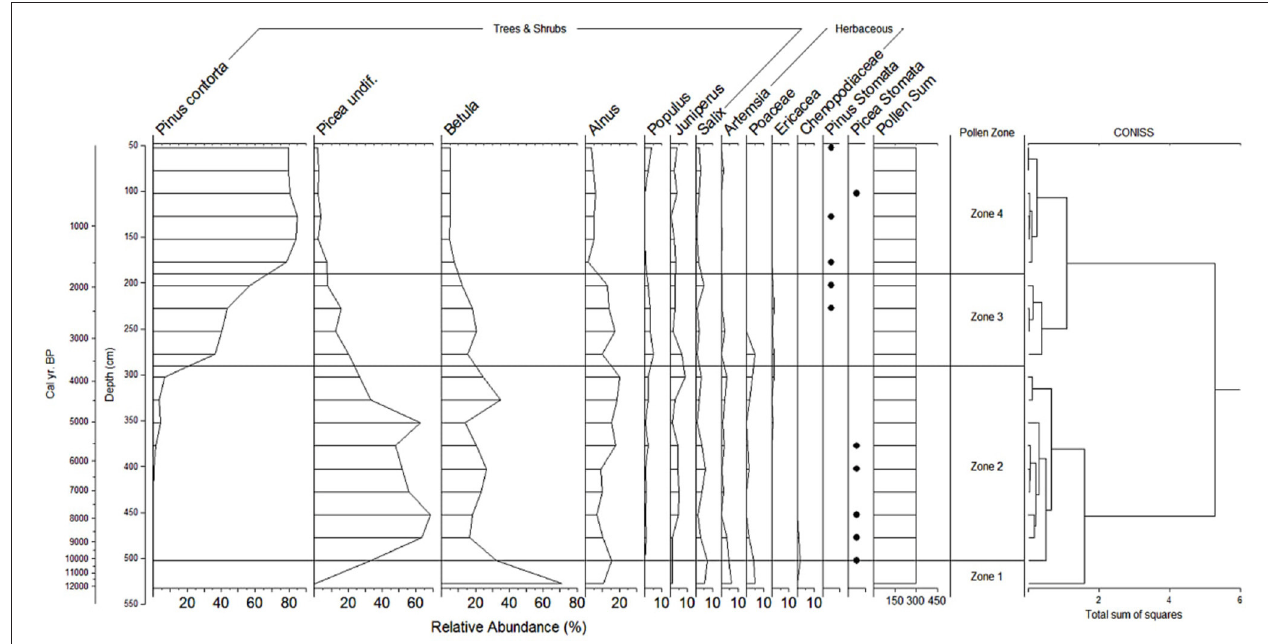
FIGURE 9 | Histogram showing Spindly Pine Lake stand establishment (5-year bins). Recent fires occurred in AD 1725, 1833, and 1892 and are represented by a red arrow. The recent fires in the catchment were determined by dating fire scars on lodgepole pine trees collected from three sites in the area surrounding Annie Lake, located within 1km of Spindly Pine Lake (Robillard, 2012). At each site, fire scar dates represent the year of fire based on multiple trees at each site.